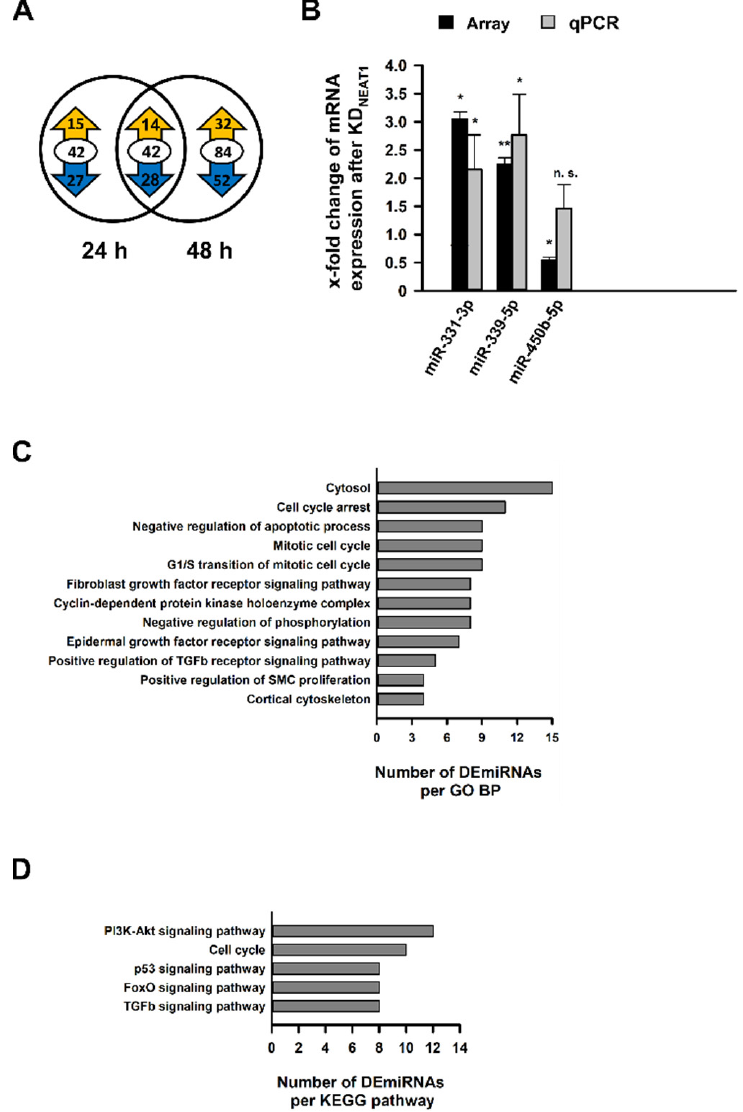
Figure 4. Analysis of differentially expressed miRNAs (DEmiRNAs) in human mesangial cells (hMCs) after NEAT1 silencing compared to negative control siRNA treated cells. ( A ) The Venn diagram indicates the number of DEmiRNAs 24 h (left) and 48 h (right) after the second NEAT1 knockdown in hMCs. The overlapping region between both circles represents miRNAs, which were differentially expressed at both times. The encircled value corresponds to the total number of DEmiRNAs, and the ciphers in the yellow or blue arrow represent the number of up- and downregulated DEmiRNAs, respectively; n = 3. ( B ) Validation of selected DEmiRNAs (miR-331-3p, miR-339-5p, miR-450b-5p) found in the microarray via qPCR. Black bars + SD show x-fold changes of gene expression in microarray (normalized to internal controls), grey bars + SD show x-fold changes of gene expression validated by qPCR (normalized to hsa-5S-rRNA); * p < 0.05; ** p < 0.001; n.s.: not significant; n = 3. ( C , D ) In-silico enrichment analyses based on DEmiRNAs, using DECGs detected by the microarray as filter. Illustrations show selected significantly enriched terms ( p < 0.05; EASE score < 0.05), which are relevant for mesangial physiology, sorted by count. The complete list is shown in the Supplement. ( C ) Functional enrichment analysis in terms of Gene Ontology (GO) Biological Processes (BP). ( D ) Functional enrichment analysis in terms of Kyoto Encyclopedia of Genes and Genomes (KEGG) pathways. Abbreviations: TGFb: transforming growth factor b; SMC: smooth muscle cell; PI3K-Akt: phosphatidylinositol 3-kinase—protein kinase B; FOXO: forkhead box